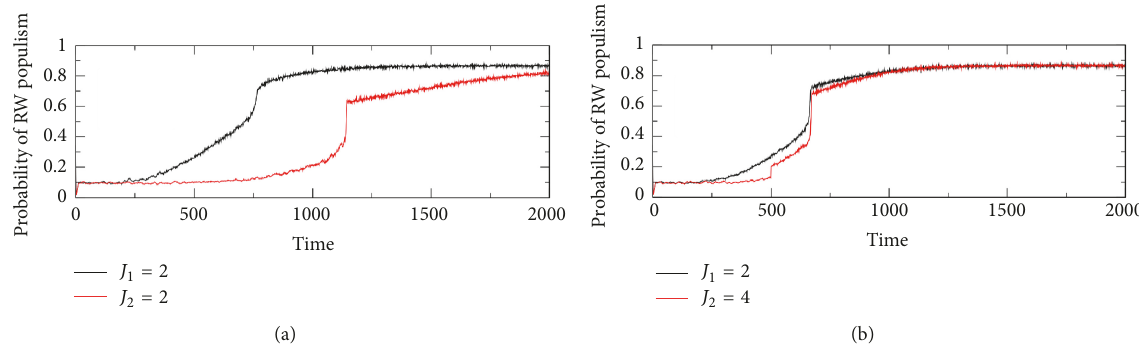
Figure 7: Interconnected networks or why “somebody else’s problem” easily turns into “my problem.” In (a) we show the case when there are no interlinks between networks. The tolerance parameters between the two networks differ, 𝑓 𝐼,1 = 0.2 and 𝑓 𝐼,1 = 0.4 , while the inflows into both networks are the same, 𝐽 1 = 𝐽 2 = 2 . (b) More tolerant network is now exposed to a higher inflow, 𝐽 2 = 4 , and a shock at 𝑡 1 = 500 . The average number of connections for intraconnections (interconnections) in both networks equals 15 (10). The other parameters are the same as in Figure